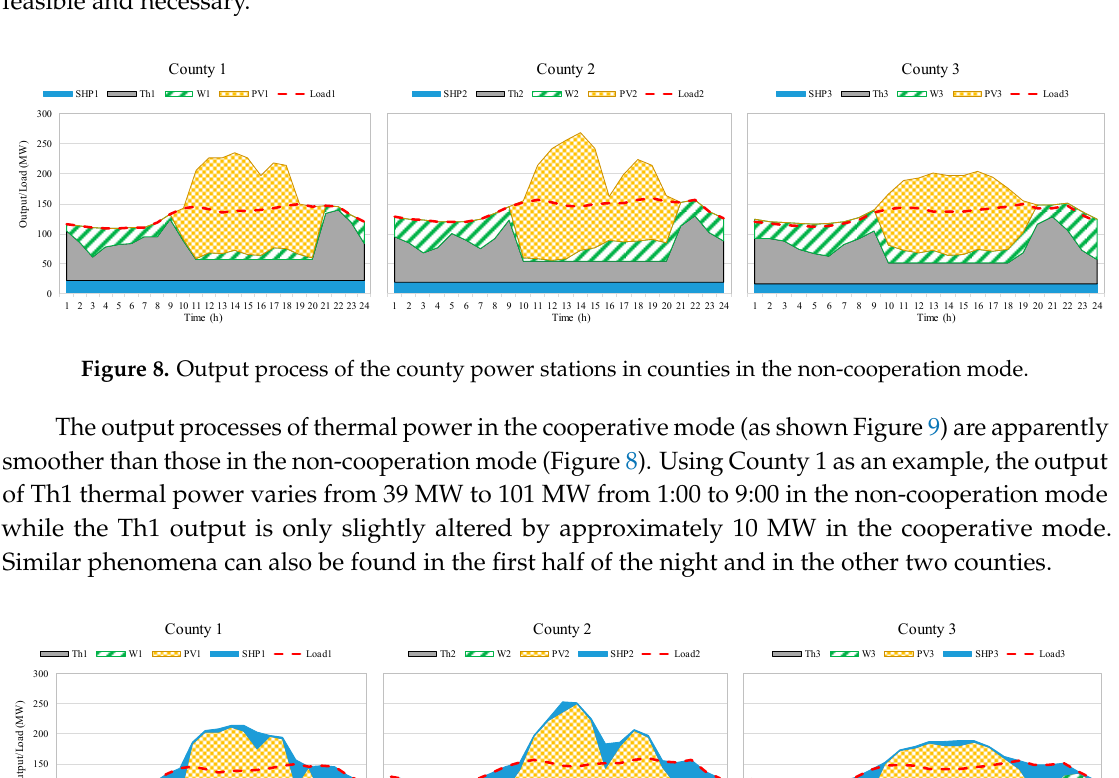
Table 1. Power production and operation costs of thermal power.